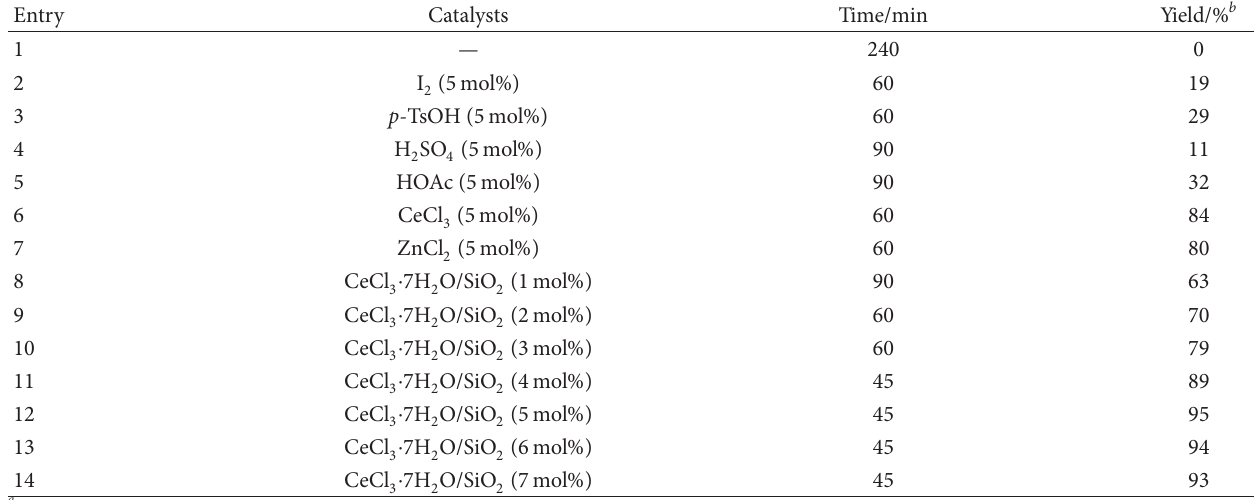
of a variety of